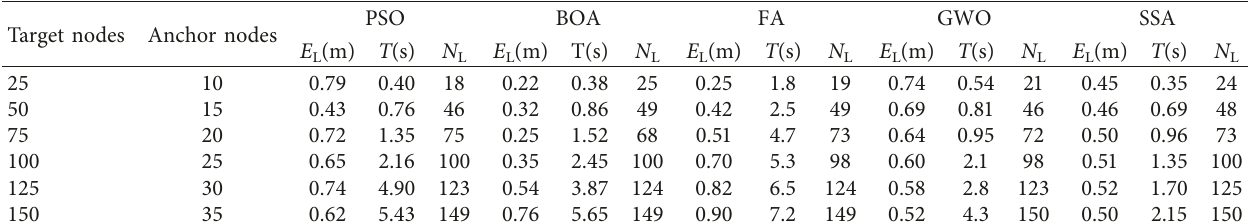
Table 3: Summary of experimental results of the different localization